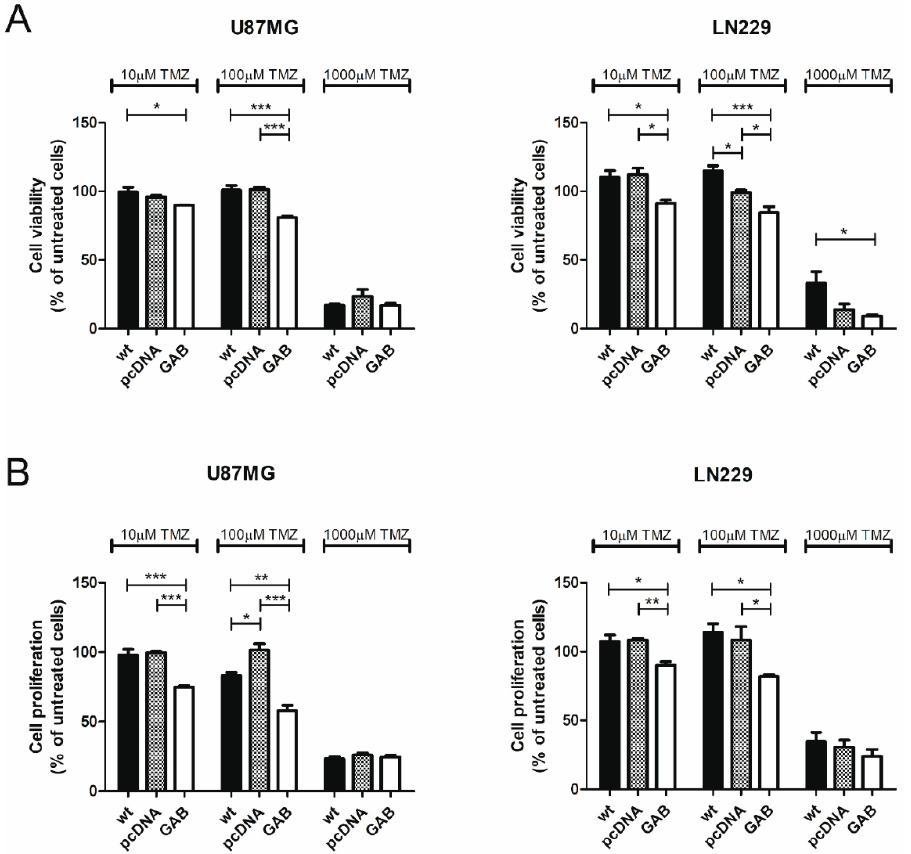
Figure 4. Transfection with the GAB sequence sensitizes U87MG and LN229 cells to temozolomide (TMZ) and diminishes viability and proliferation. ( A ) Wild type (wt) cells or cells stably transfected with the indicated plasmids (U87MG cells left panel and LN229 cells right panel) were exposed to increasing concentrations of TMZ for 72 h, and then mitochondrial activity was assessed by the MTT test. Results are mean ± SD ( n = 4) expressed as a percentage of untreated cells. * p < 0.05, *** p < 0.001 versus wt and pcDNA cells (one-way ANOVA followed by Tukey’s test). ( B ) Cell proliferation of wild type (wt) cells or cells stably transfected with the indicated plasmids (U87MG cells left panel and LN229 cells right panel) were exposed to increasing concentrations of TMZ for 72 h, and then cell proliferation was assessed by the BrdU assay. Results are mean ± SD ( n = 4) expressed as a percentage of wt cells. * p < 0.05, ** p < 0.01, *** p < 0.001 versus wt and pcDNA (one-way ANOVA followed by Tukey’s test).